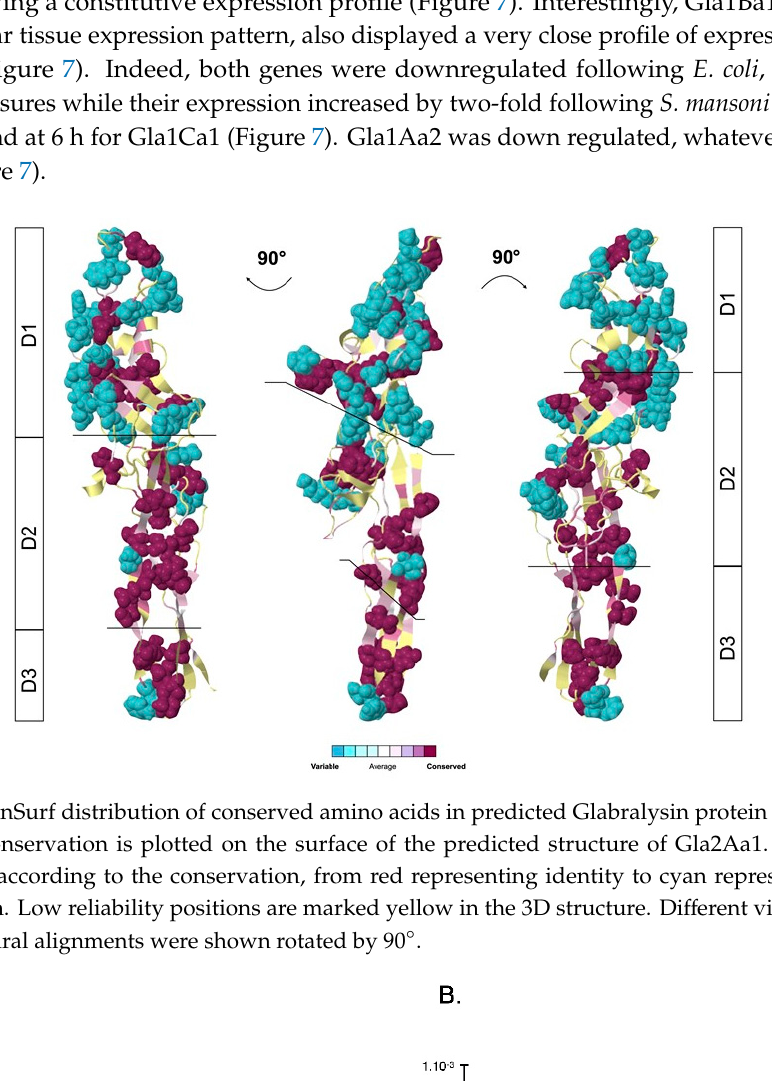
Figure 5. ConSurf distribution of conserved amino acids in predicted Glabralysin protein structures. Sequence conservation is plotted on the surface of the predicted structure of Gla2Aa1. Residues are colored according to the conservation, from red representing identity to cyan representing no conservation. Low reliability positions are marked yellow in the 3D structure. Different views of the same structural alignments were shown rotated by 90°.